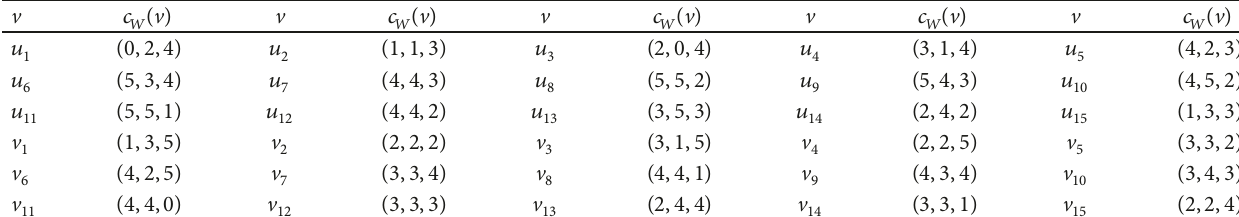
Table 4: The code 𝑐 𝑊 ( V ) of V with respect to 𝑊 = {𝑢 1 ,𝑢 3 , V 11 } in 𝑃(15,3) .